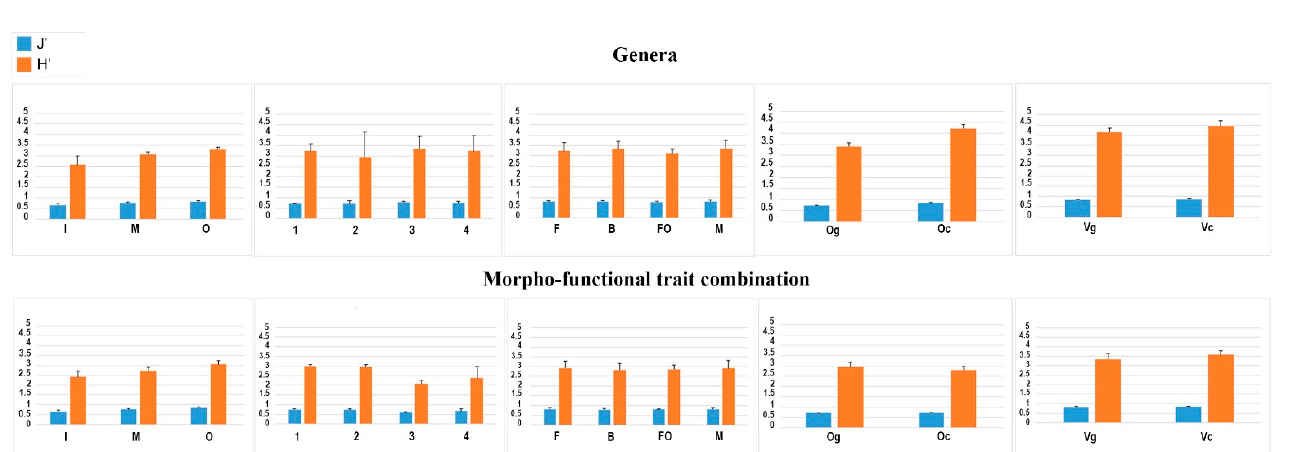
Figure 9. Trends of the Shannon diversity (H’) and Pielou evenness (J’) computed on the matrixes based on genus and combination of morpho-functional traits for each study case.